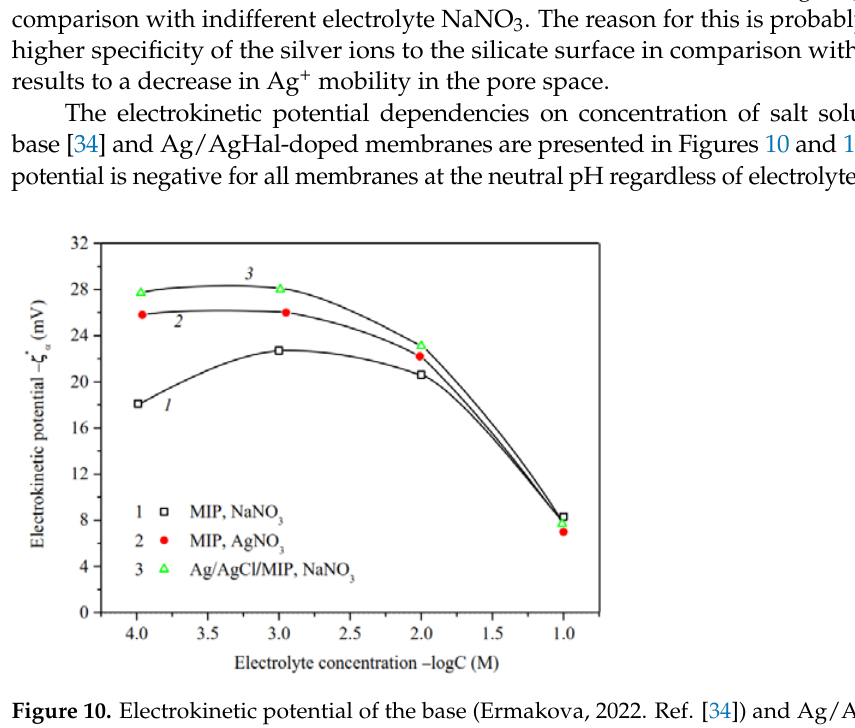
Figure 10. Electrokinetic potential of the base (Ermakova, 2022. Ref. [34]) and Ag/AgCl-modified MIP membranes vs. the concentration of NaNO 3 and AgNO 3 solutions.